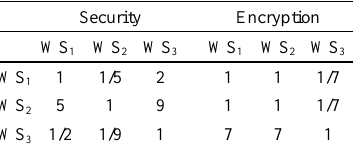
Table 8. Comparison matrices for Case 2